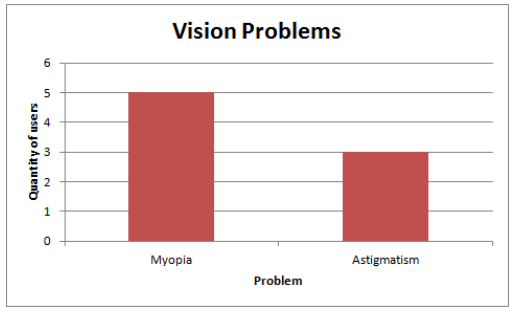
Figure 13. Vision problems declared by the respondents.